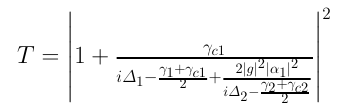
Fig. 1b. Nonlinearly, when increasing the signal amplitude α 1 , the CPA dip will diminish, allowing a portion of the light to be transmitted, termed as self-induced